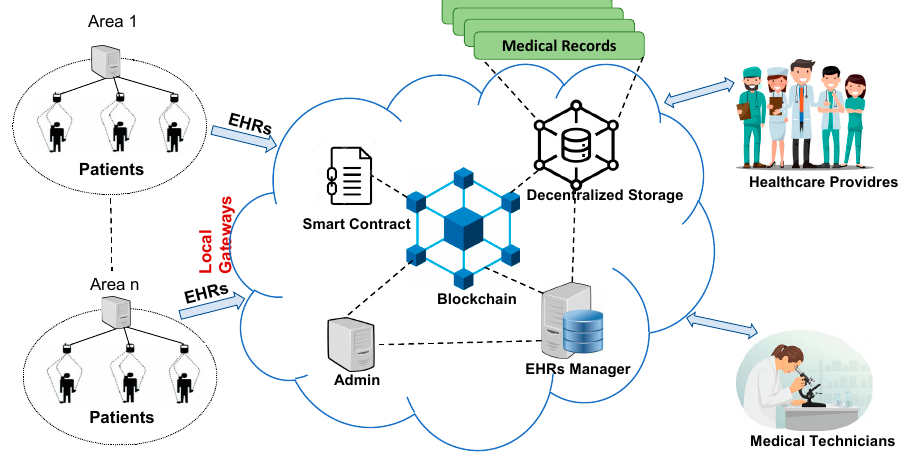
Figure 2. The Blockchain-based Healthcare System on a Mobile Cloud.